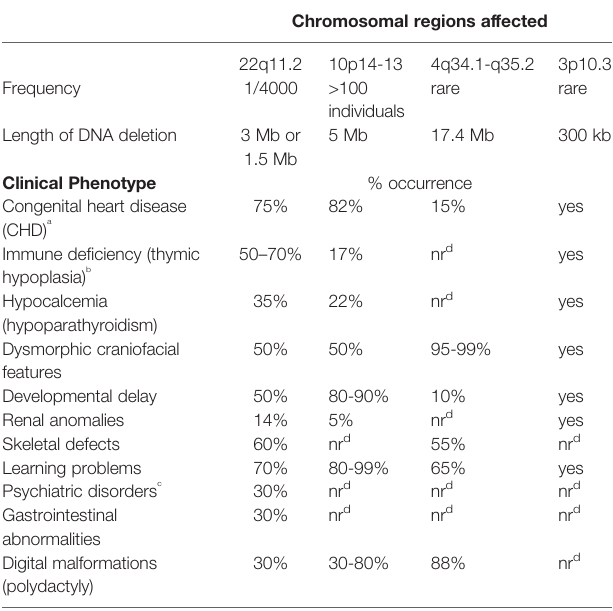
TABLE 1 | Clinical manifestations of 22q11.2 and 22q11.2-like deletion